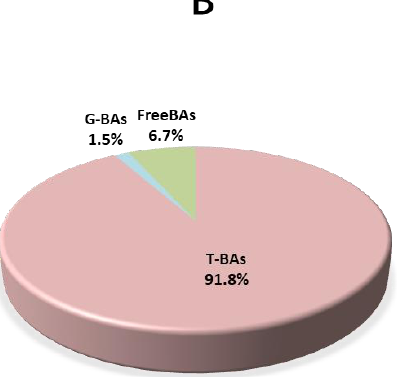
Figure 7. Supplement bile acids to a high plant protein diet increase the proportion of Glycine-conjugation bile acids significantly, while Tauro-conjugation bile acids decreased unremarkably in carp bile, ( A , B ) for HP and HP+BAs, respectively ( n = 7).